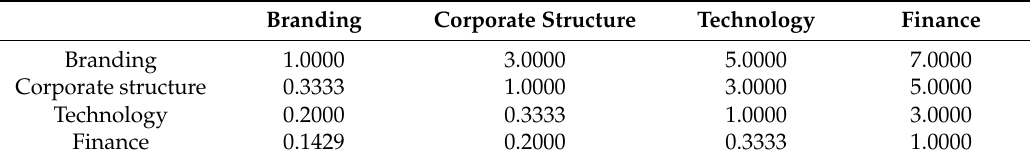
Table 7. A Group AHP Decision Matrix.